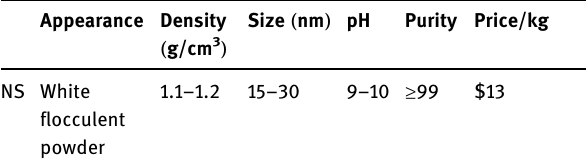
Table 2: Physical properties of NS solution Appearance Density Size ( nm ) pH ( g/cm 3 )